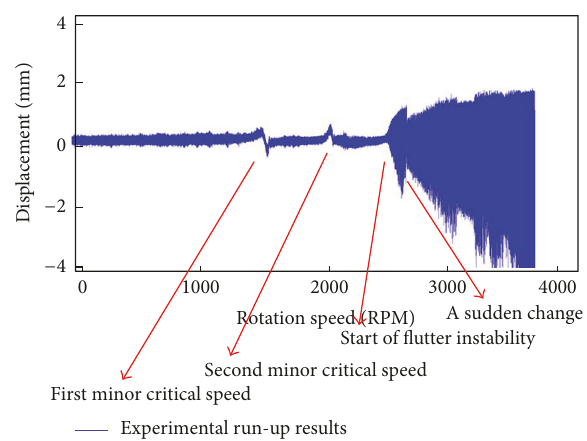
Figure 14: Deflection of the blade, during run-up, measured by probe 90 ∘ .